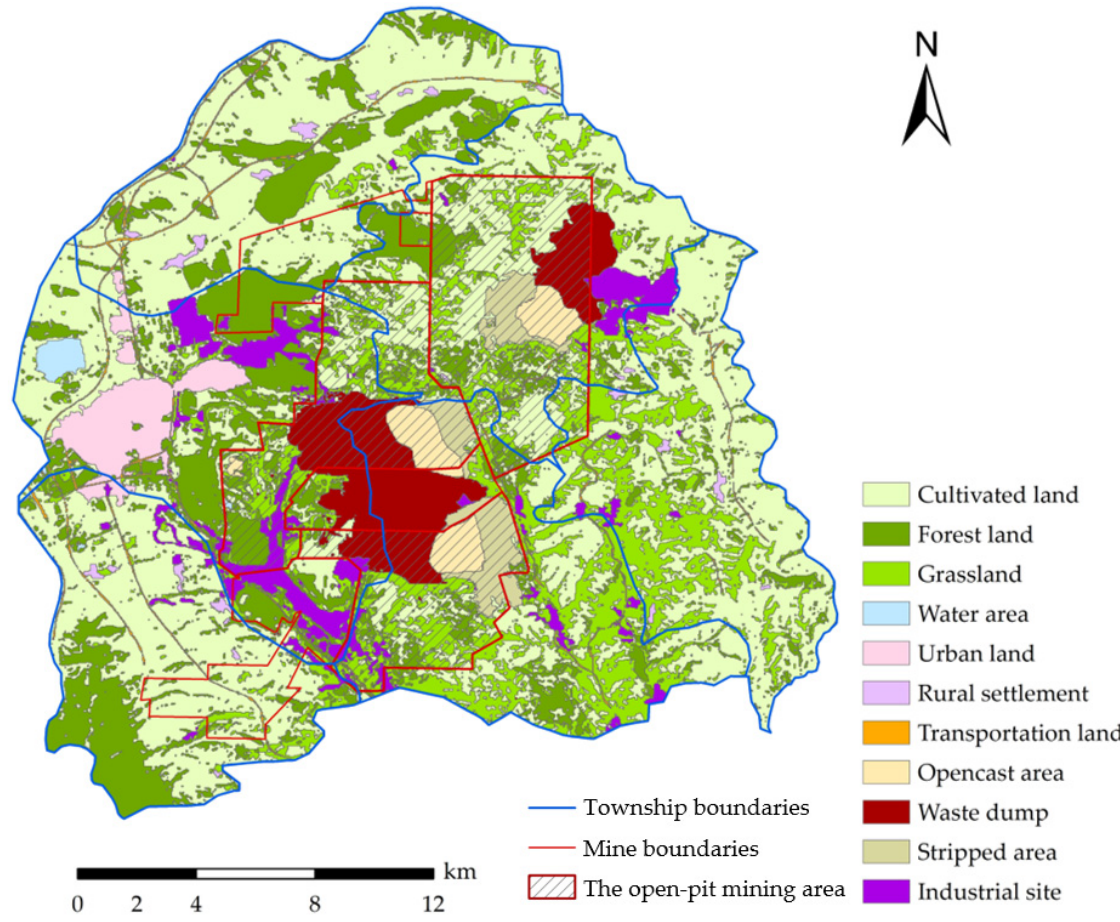
Figure 2. The status of land use in the typical compound area mine–agriculture–urban.